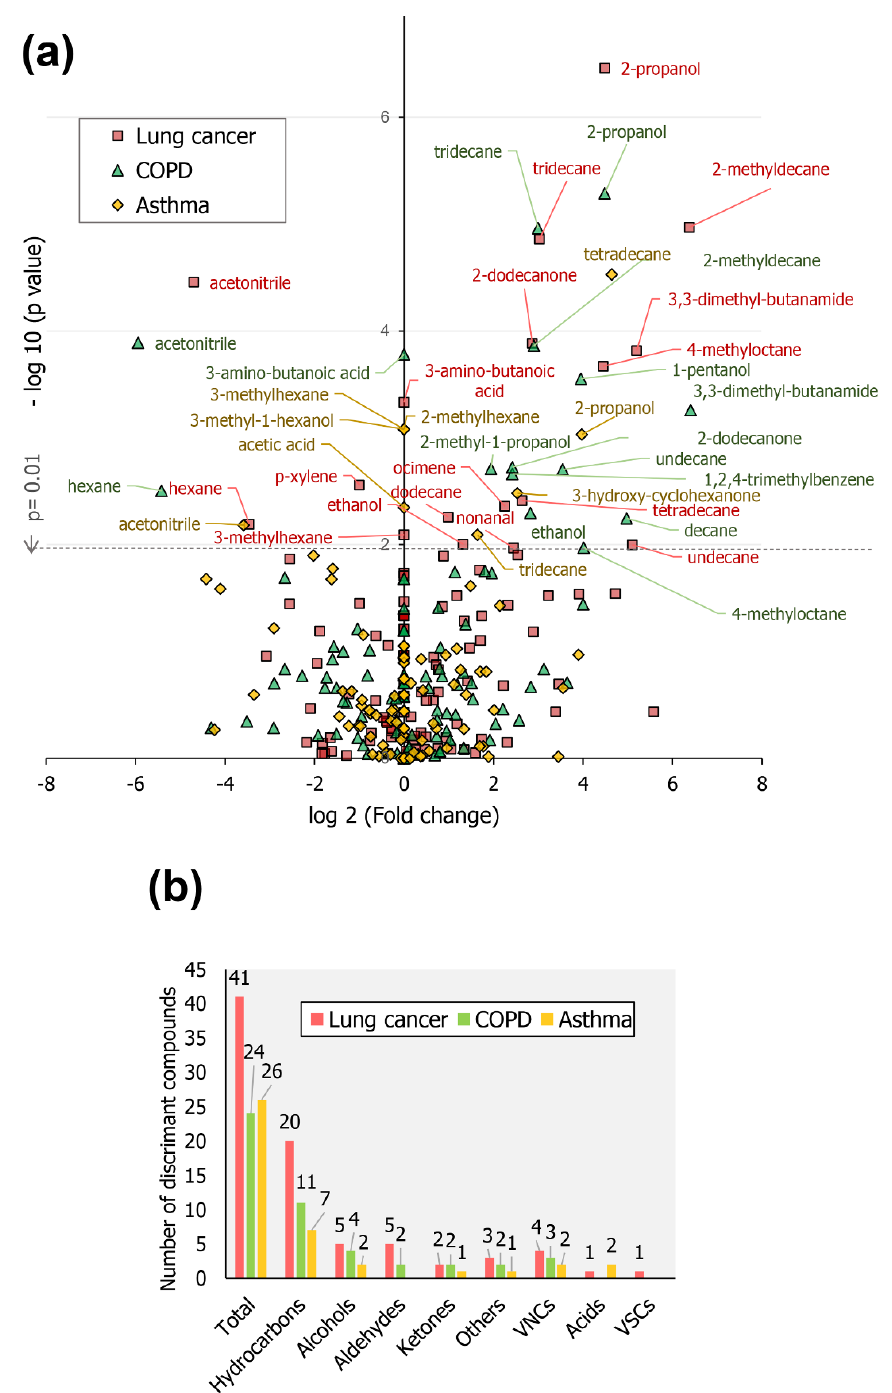
Figure 3. ( a ) Volcano plot displaying the most discriminating features, in terms of fold change ( x -axis) and statistical relevance ( y -axis), in which the dashed line represents the point of y -axis in which p = 0.01; ( b ) Graph of distribution of number of all compounds assigned as discriminating features, according to disease and chemical class (significance criteria: p ≤ 0.05).